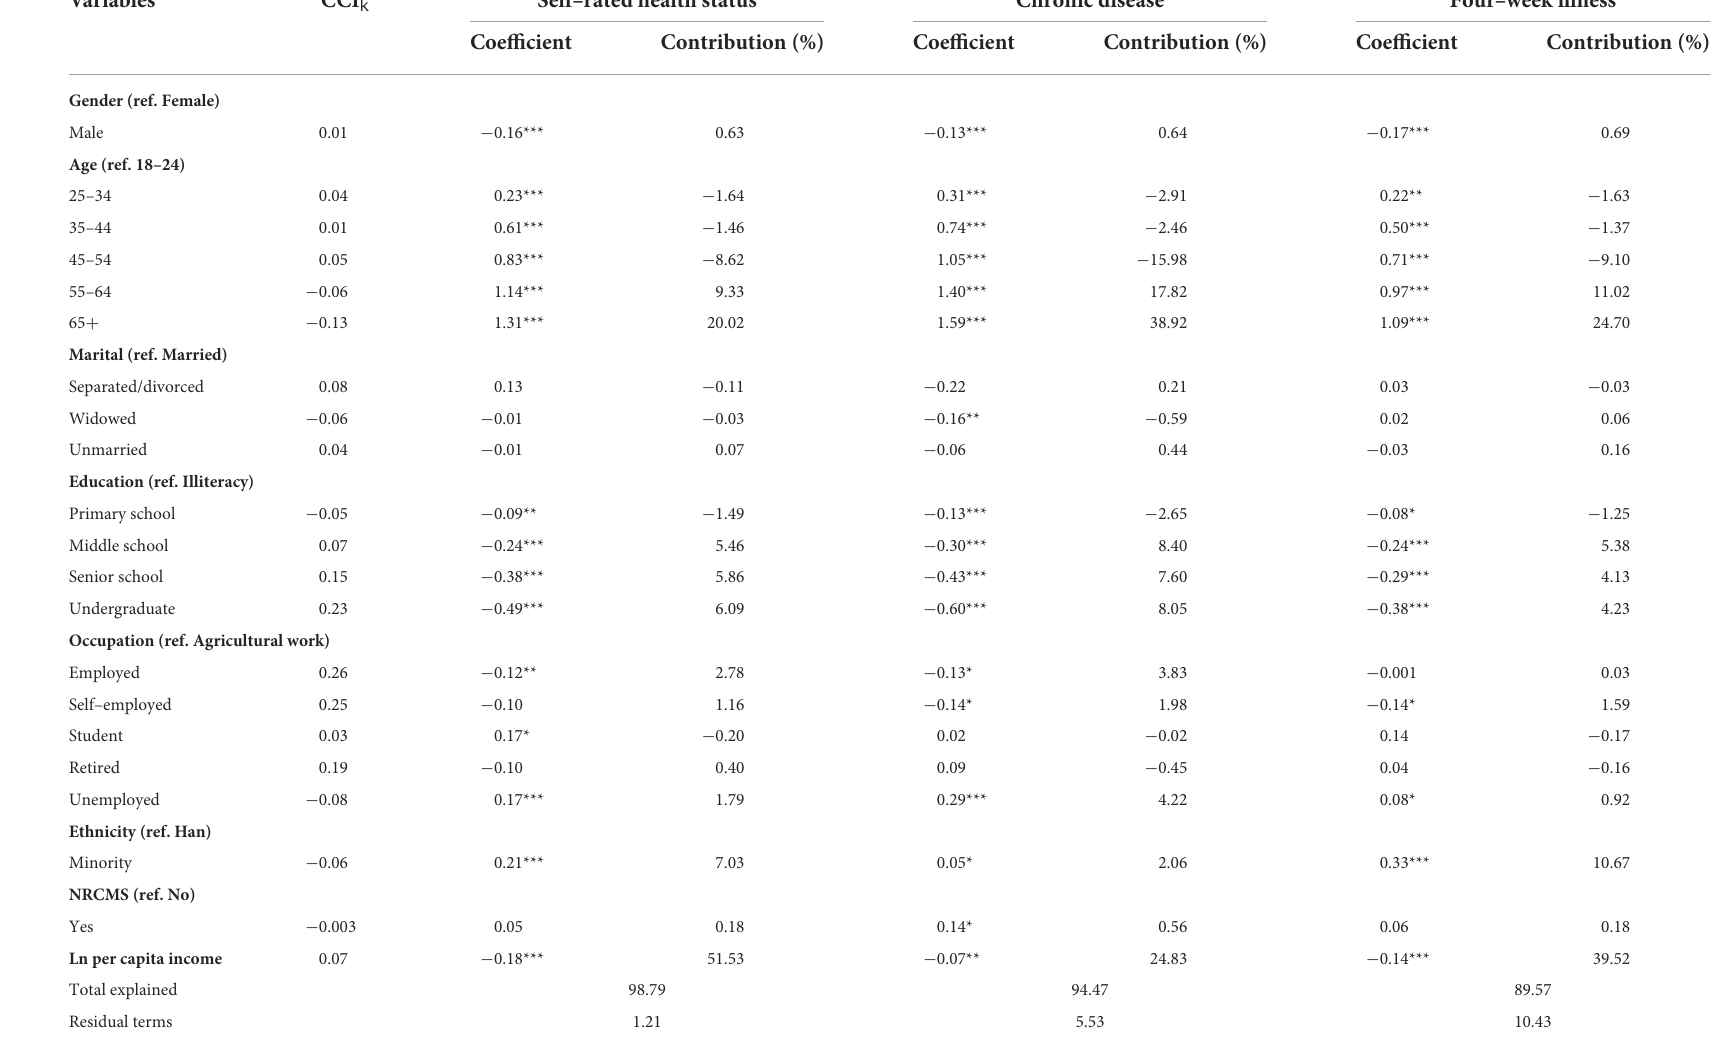
TABLE 3 Decomposition of concentration index for health status of Chinese western rural adults in 2014 ( N = 14,555). Variables